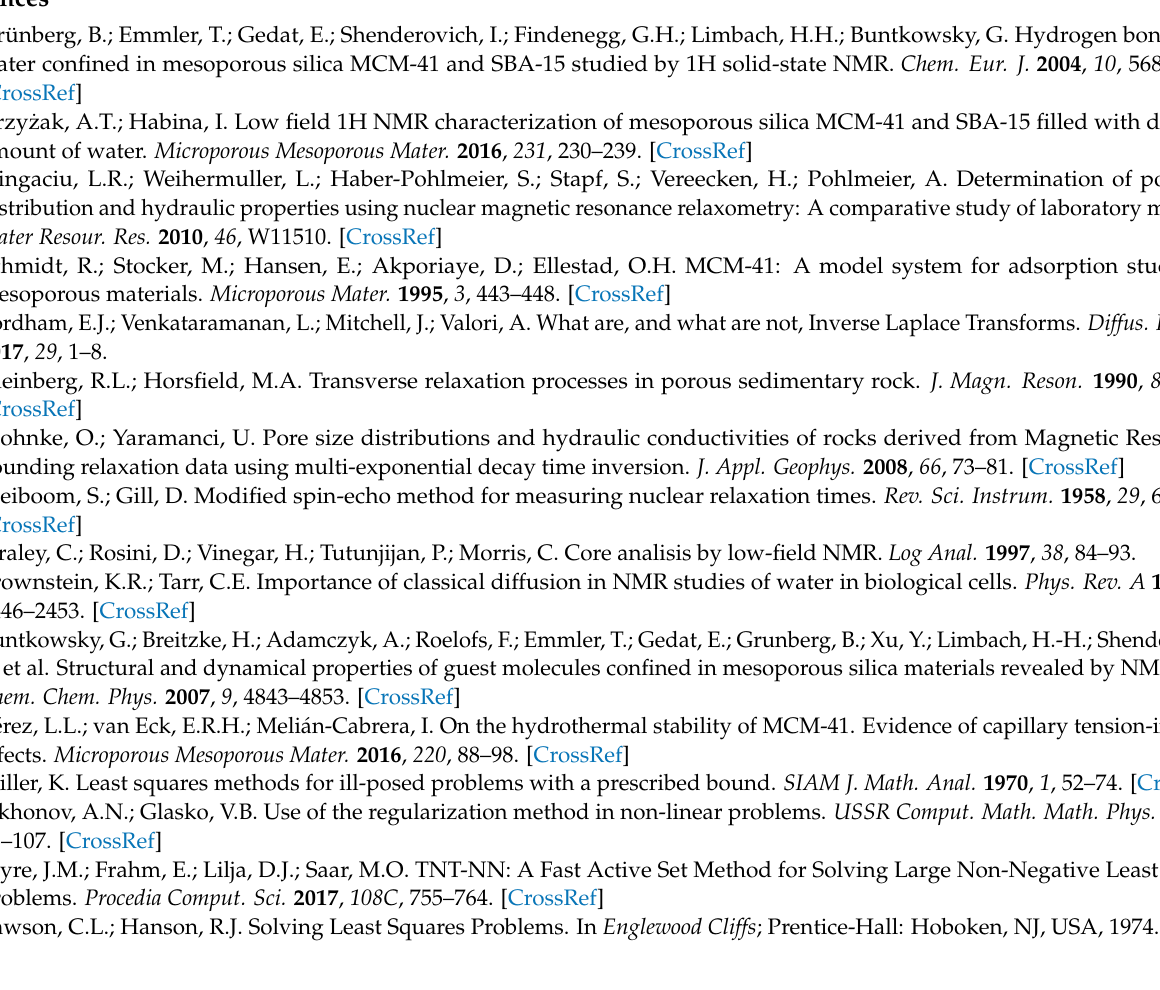
Ratio) decreases.